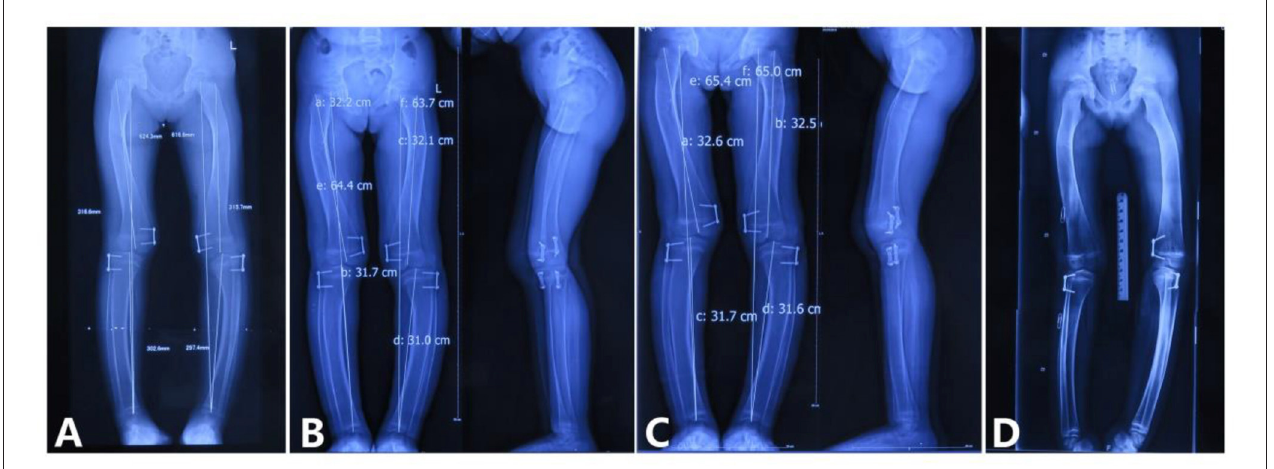
FIGURE 6 | Correction of the lower limb deformity via the second harf epiphysiodesis surgery [shows lower limb deformity and tortuous lower limbs; (A) age 5 years and 3 months, 3 months after surgery; (B) age 5 years and 8 months, 9 months after surgery; (C) age 5 years and 11 months, 11 months after surgery; (D) age 6 years and 6 months, 1 year and 6 months after